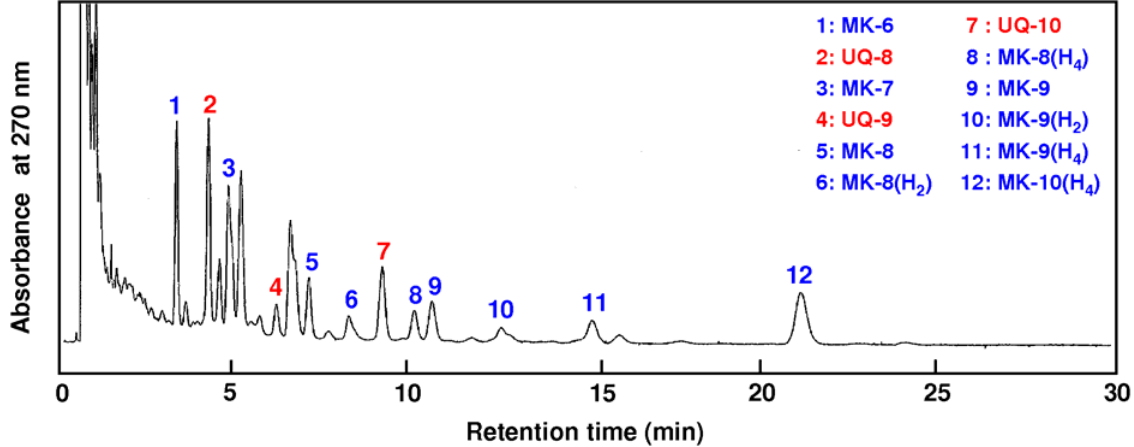
Figure 4. UPLC chromatograms of ubiquinones (UQ) and menaquinones (MK) extracted from anaerobically digested sludge under scCO cartridge